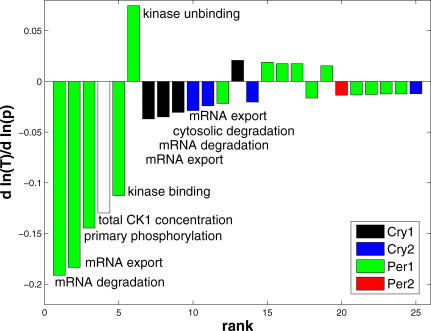
Top 25 Ranked Period Sensitivities When mRNA Degradation Rate and Primary Phosphorylation Rate for Per1 and Per2 Were ReversedThe color assignment is identical to Figure 2.